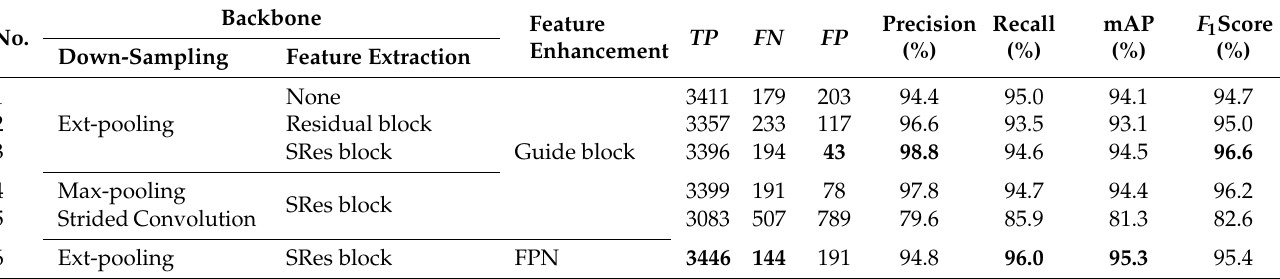
Table 3. Different configurations of the proposed